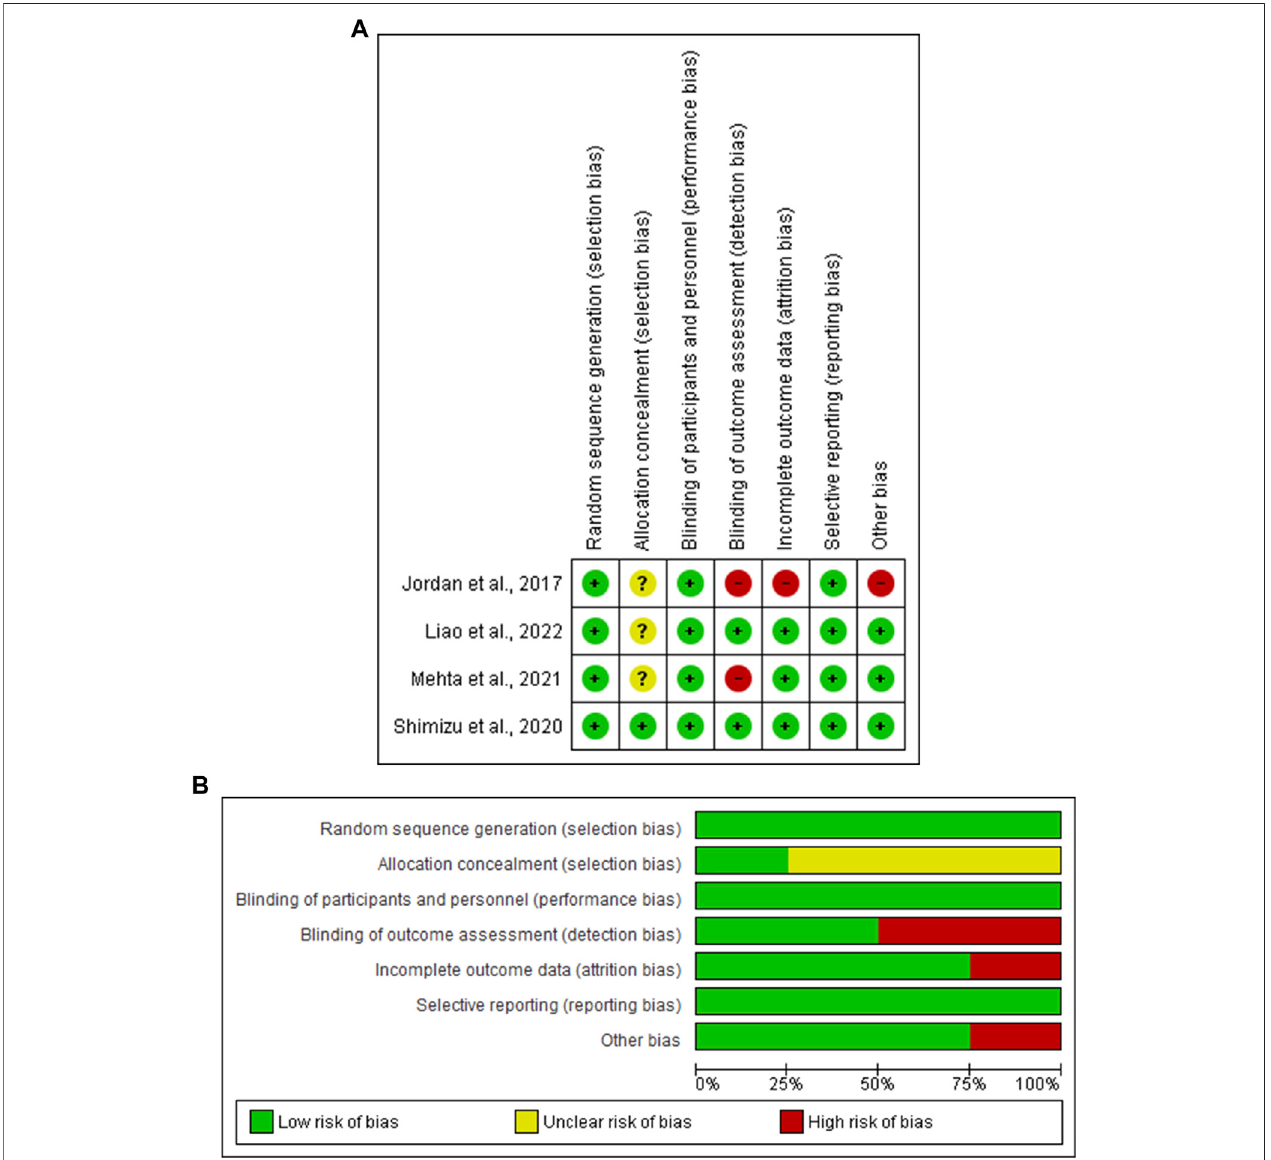
FIGURE2 |(A) Risk of biasgraph, (B) Risk ofbias summary:review authors ’ judgments about each riskofbias item presented aspercentages across all included studies.